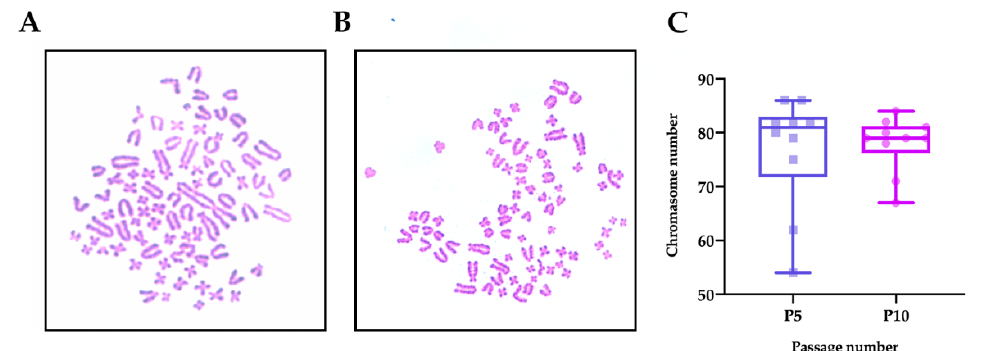
Figure 6. Chromosome analysis of RLKs. ( A , B ) Representative images of Giemsa-stained metaphase spreads of RLKs at passage 5 and passage 10, respectively. ( C ) Box-and-whisker plots showing the distribution of the chromosome numbers in RLKs at passage 5 and 10 ( n = 10 metaphase spread counts). Note: Due to the high number of chromosomes in the cells, the errors in the counting of chromosome numbers were within ± 2 chromosomes.